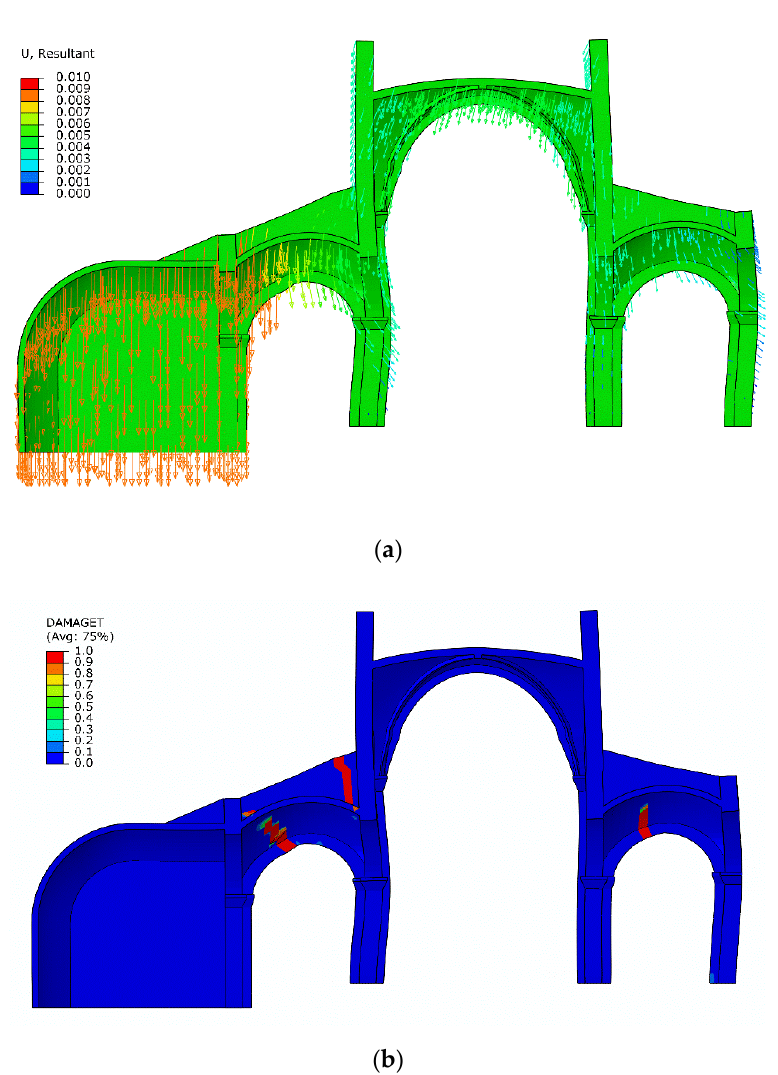
Figure 18. Simulation of support settlement: ( a ) displacements and ( b ) damage in tension.